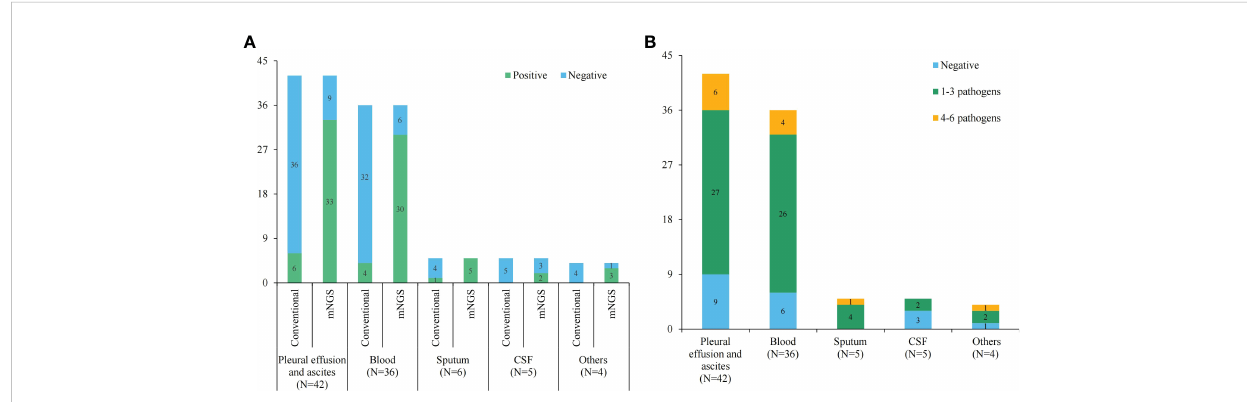
FIGURE 2 The statistics of conventional and mNGS pathogen tests. (A) The positive and negative rates of conventional and mNGS pathogen tests in different sample types; (B) histogram showing detected pathogens of mNGS test in different sample